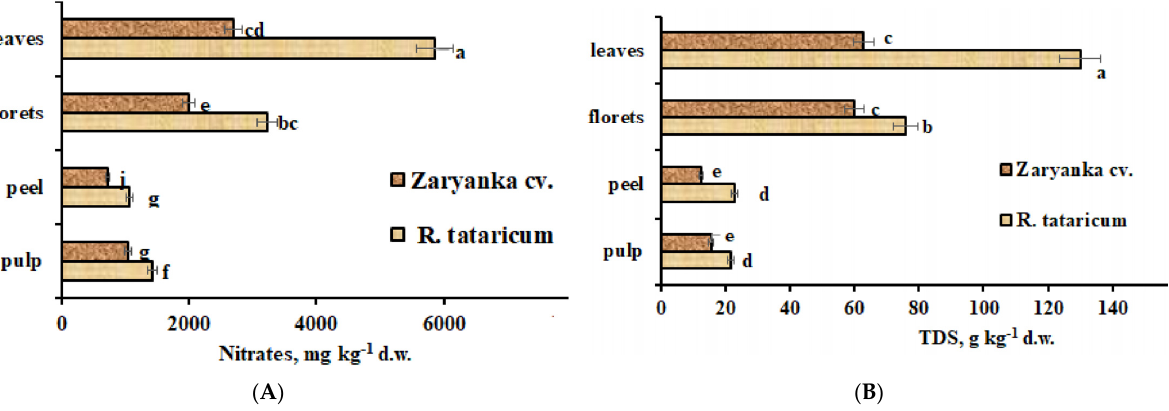
Figure 5. Nitrates ( A ) and total dissolved solids (TDS) ( B ) accumulation in R. tataricum and garden rhubarb cv. Zaryanka. Values with the same letters do not differ statistically according to Duncan’s test at p < 0.05.